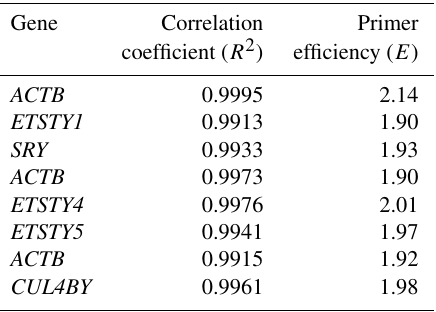
Table 3. Correlation coefficient of standard curve and primer effi- ciency for ACTB and five Y chromosome genes.